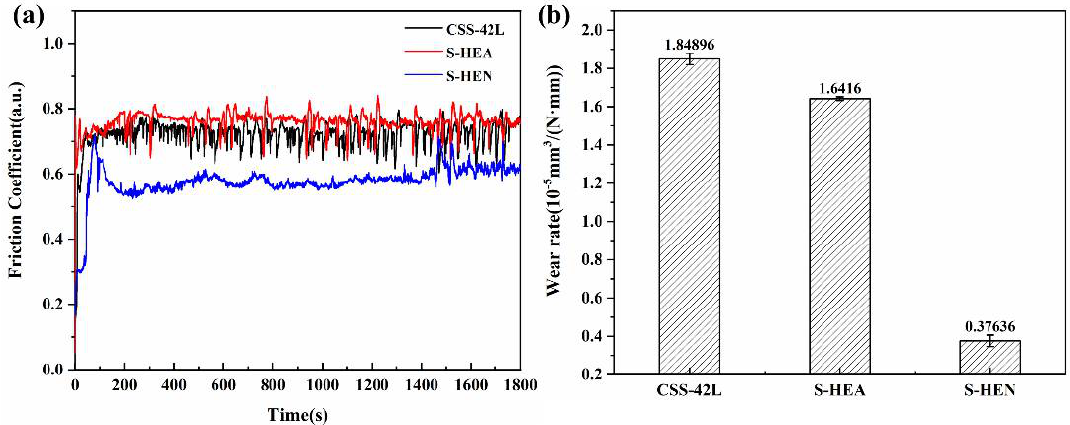
Figure 6. ( a ) The friction coefficient curve of CSS-42L steel and S-HEA sample, S-HEN sample l, ( b ) wear rate of CSS-42L steel and S-HEA sample, S-HEN sample.